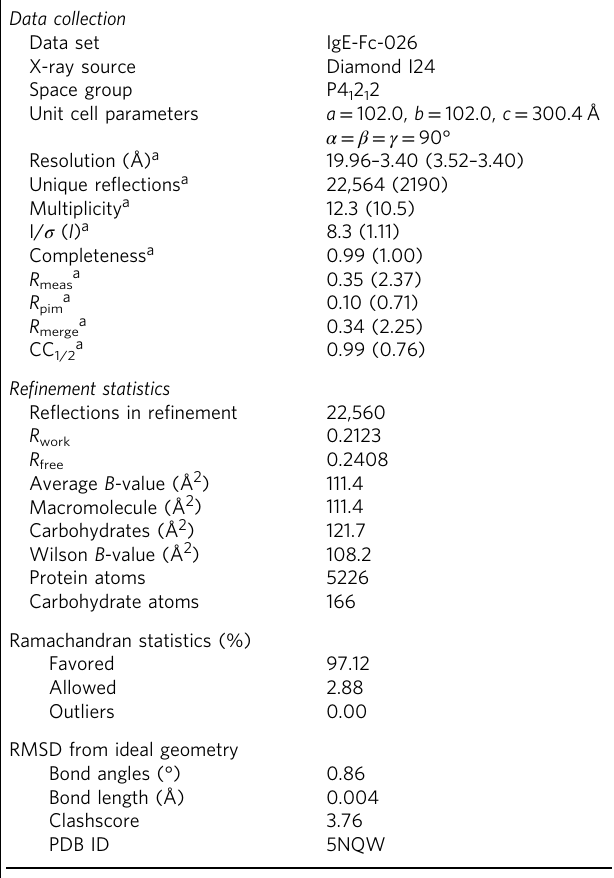
Table 1 Data collection and re fi nement statistics Data